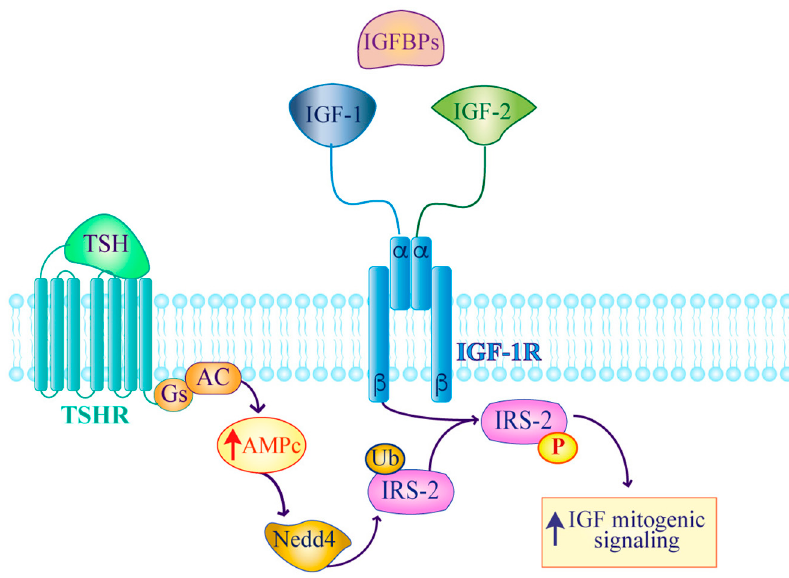
Figure 2. Working model depicting how the TSH / Nedd4 / IRS2 axis improves IGF mitogenic activity. cAMP-stimulating agents such as TSH, promote Nedd4-dependent ubiquitination of IRS-2 thereby assembling a Nedd4-IRS-2 complex that enhances IGF-dependent mitogenic signaling. AC: Adenylyl cyclase; Gs: G Protein